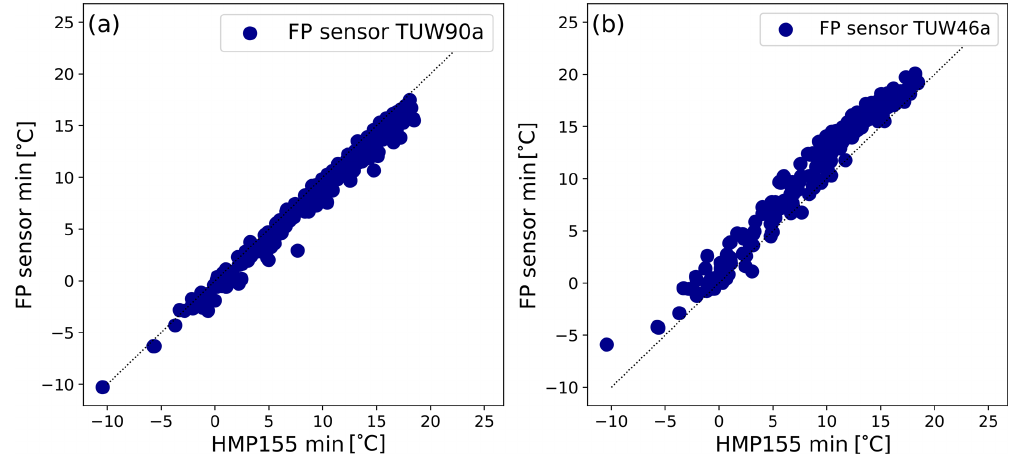
Figure A1. Scatter plots of the minimum temperatures observed with the conventional probe HMP155 and the FP sensors (a) TUW90a and (b) TUW46a.